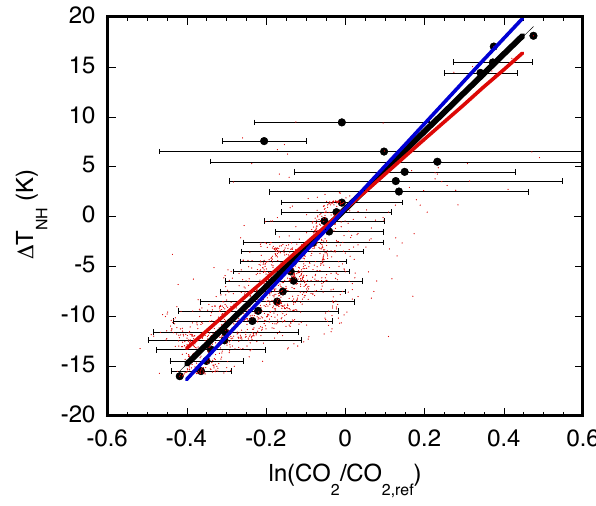
Fig. 5. The selected ( n = 1302) proxy CO 2 data (red dots) binned in intervals of 1K NH temperature change. The error bars represent one standard deviation variability of the data in the selected temper- ature interval. The additional lines show the range in C values from different weighing tests, blue C +10%, red C − 10%. The slope of the regression line corresponding to C is 39 ±